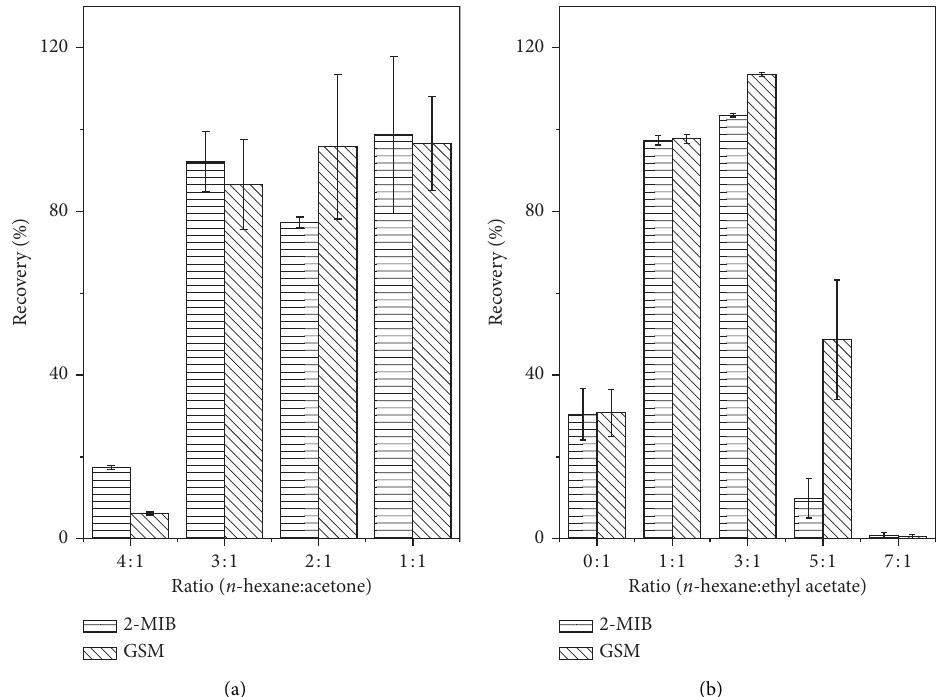
Figure 3: Recovery of 2-MIB and GSM with n -hexane and acetone mixture (a) or n -hexane and ethyl acetate mixture (b) as elute on silica cartridge. Spiked concentration: 100ng/mL.